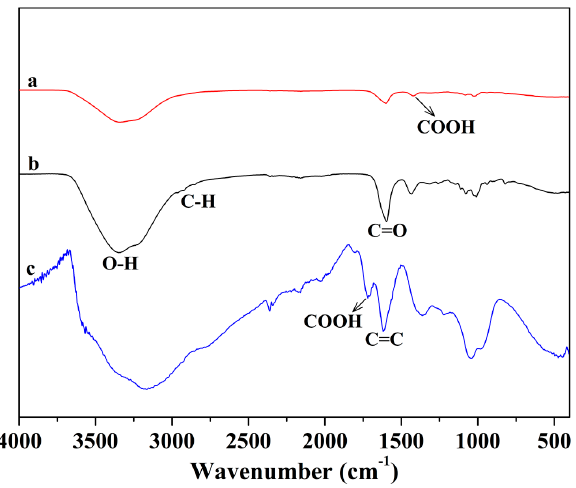
Figure 2. FT-IR spectra of (a) mp-CA/GO, (b) CA and (c) GO.